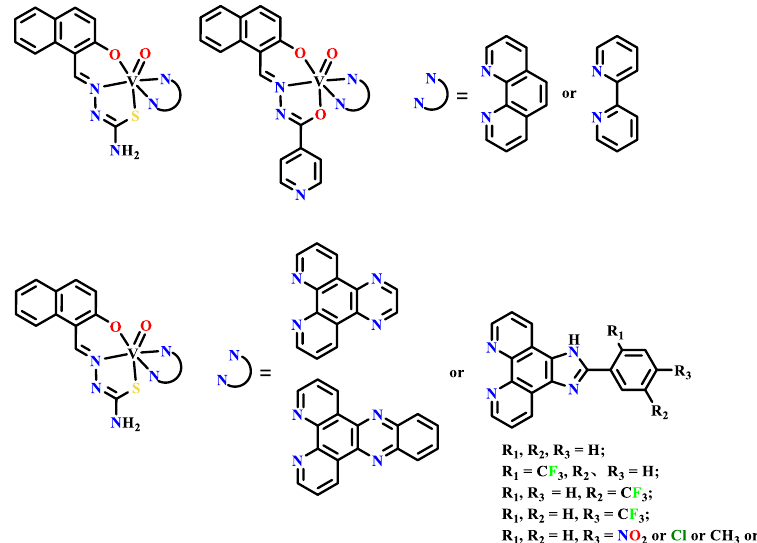
Figure 17. Several vanadium(IV) complexes of naphthylhydrazone ligand with thiourea or isonia- zide side